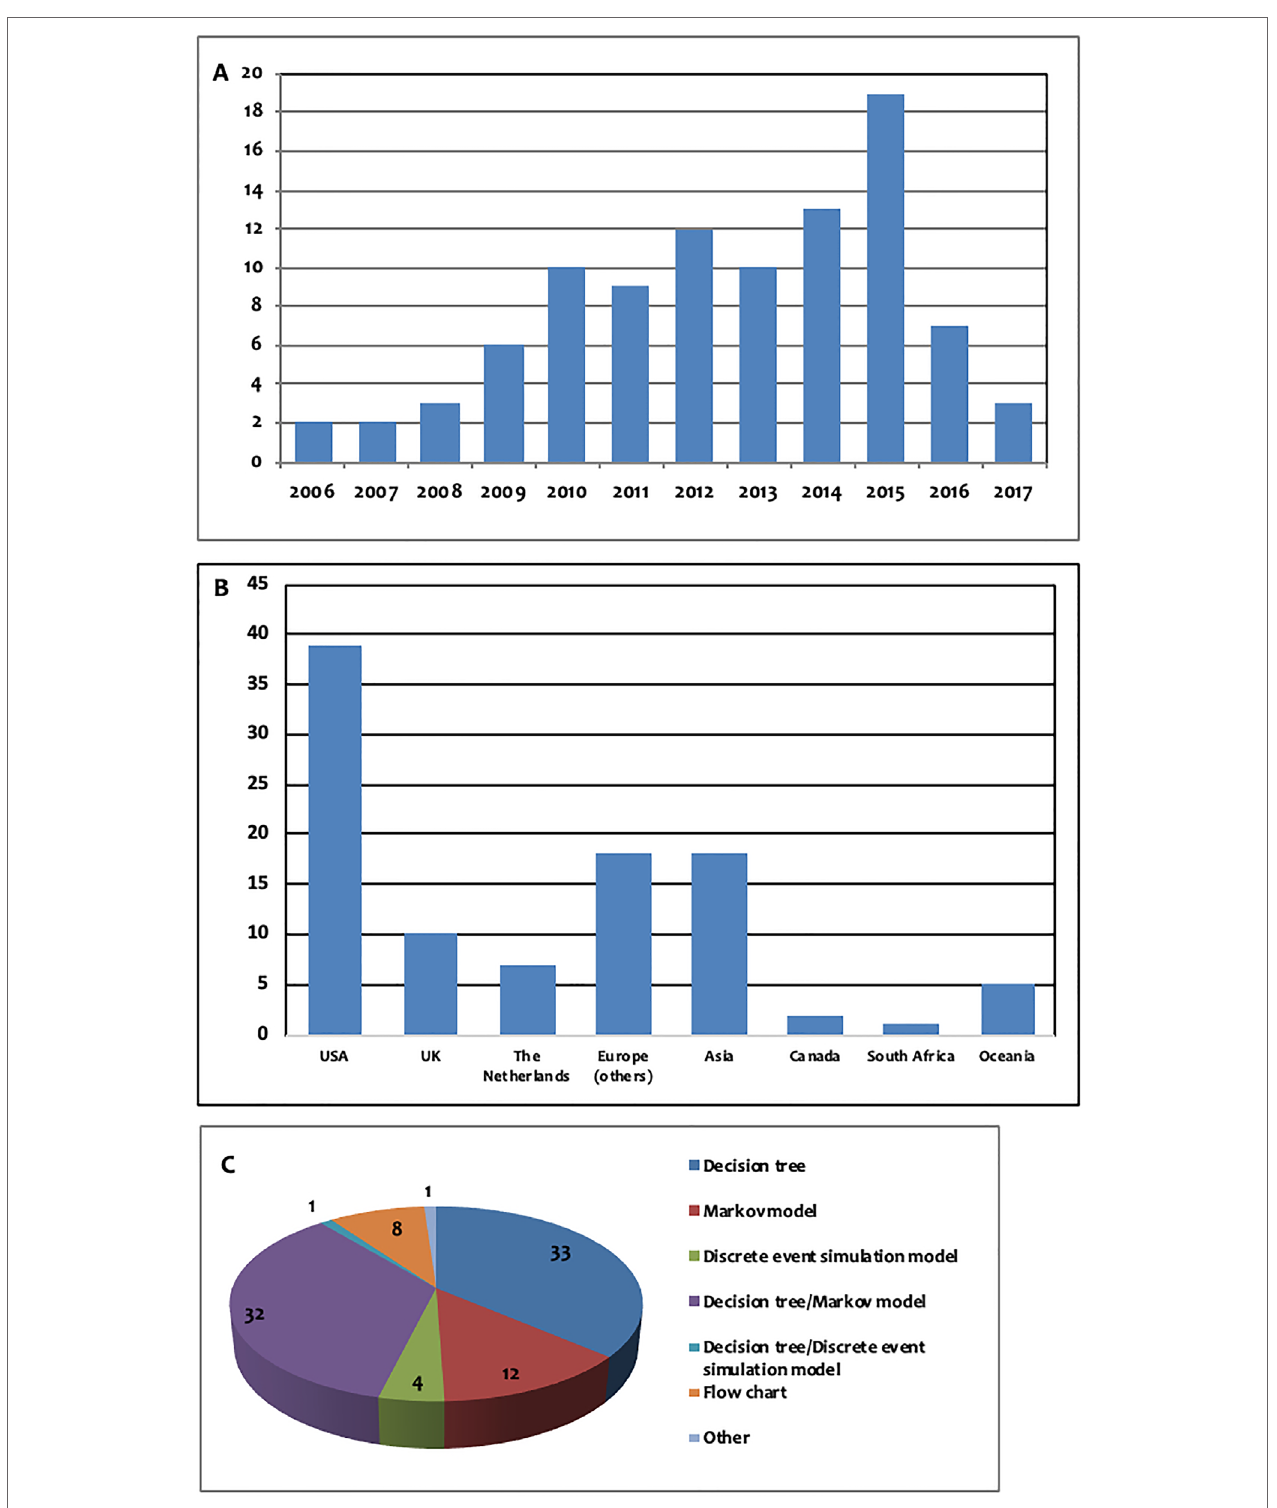
FIGURE 2 | (A) Number of publications per year, (B) : number of publications per continent/country: Europe (others): Austria ( n = 1), France ( n = 2), Germany ( n = 2), Denmark ( n = 1), Switzerland ( n = 3), Sweden ( n = 1), Spain ( n = 5), Italy ( n = 1), Croatia ( n = 1), Serbia ( n = 1), Asia: China ( n = 5), Japan ( n = 3), South Korea ( n = 1), Singapore ( n = 4), Thailand ( n = 3), Oceania: Australia ( n = 3), New Zealand ( n = 2), (C) : models used for measurement of future costs and